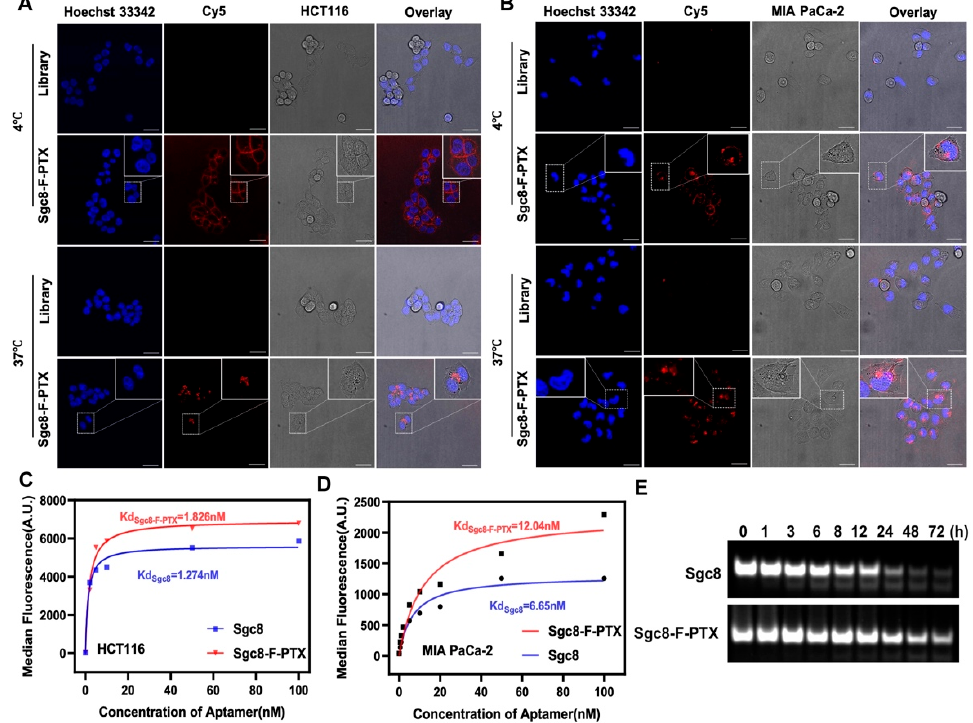
Figure 2. ( A , B ) Confocal laser scanning microscopy (CLSM) imaging of cells. HCT116 cells ( A ) and MIA PaCa-2 cells ( B ) were incubated with 500 nM cy5-labeled Sgc8-F-PTX or library at 4 ◦ C